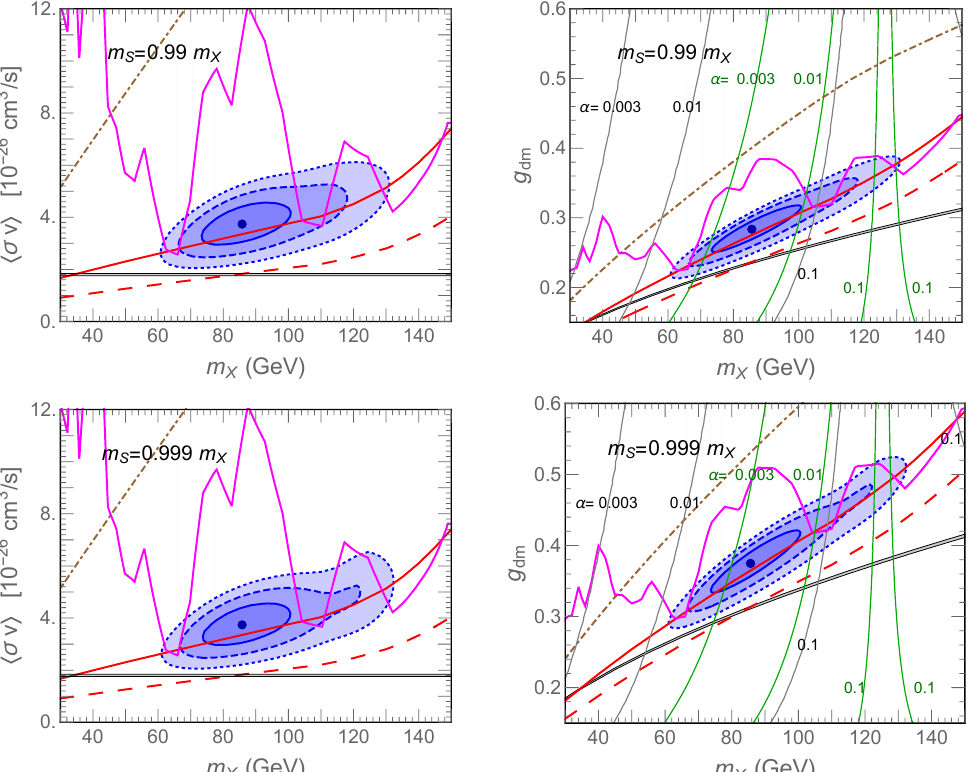
Figure 6 . Left panel: GC allowed regions for a generic Higgs portal DM model, using (cid:26) (cid:12) = 0.4 GeV/cm 3 and (cid:13) = 1 : 2 in the gNFW pro(cid:12)le. The dot denotes the best-(cid:12)t, and blue contours correspond to p -values = 0.3 (solid), 0.15 (dashed), and 0.05 (dotted). For (cid:11) & 2 (cid:2) 10 (cid:0) 6 , the correct relic density in the WIMP scenario is accounted for by the narrow gray range, while for (cid:11) . 2 (cid:2) 10 (cid:0) 6 , a larger annihilation cross section could be needed. The 95% C.L. bound from the Fermi-LAT NFWc gamma-ray line search within the ROI: R GC = 3 (cid:14) is depicted by the solid magenta line. The current Fermi-LAT dSph limit at 95% C.L. and its projected sensitivity are depicted as the solid and long-dashed red lines, respectively, while the Planck CMB 95% C.L. bound is sketched as the dot-dashed brown line. Right panel: same notations as the left panel but in the ( m X ; g dm ) plane for the secluded vector DM model. The 95% C.L. bounds from XENON1T and LZ projected sensitivity are indicated by the gray and green lines, which, with (cid:11) values denoted, correspond to the use of (cid:26) (cid:12) = 0 : 4 GeV/cm 3 ; in the region m X < m h (or m X > m h ), the r.h.s. (or l.h.s.) of each line is